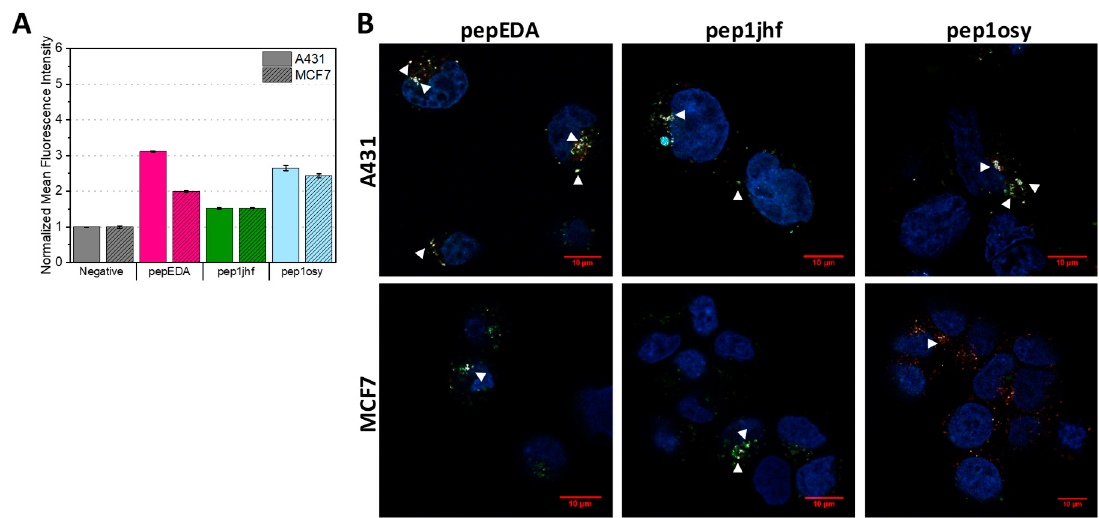
Figure 2. Binding properties of EGFR-targeting peptides to A431 and MCF7 cells. ( A ) Flow cytometry analysis of cyclic peptides incubated with A431 (uniform color) and MCF7 (shaded color) cells at 20 µ M for 15 min at 37 ◦ C. Data are represented as mean ± SD for two independent experiments and are given relative to the negative (i.e., bu ff er control). Raw data are given in Figure S3. ( B ) Live cell imaging of cyclic FAM-labeled peptide variants incubated with A431 and MCF7 cells for 10 min at 5 µ M. Nuclei and lysosomes were counterstained using NucBlue and Lysotracker DND-99, respectively and merged images are shown. Colocalization of Lysotracker DND-99 and FAM-labeled peptide is indicated with white triangles. Fluorescence microscopy was performed at 63 × magnification using an inverted laser scanning Zeiss LSM780 microscope. Scale bars are highlighted in red and represent 10 µ m. Single images can be found in Figure